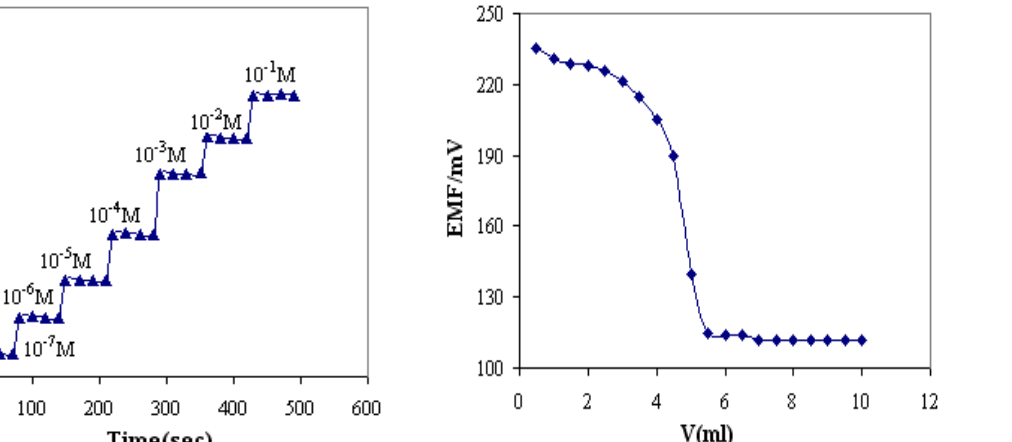
J. Water Environ. Nanotechnol., 4(3): 244-250 Summer 2019